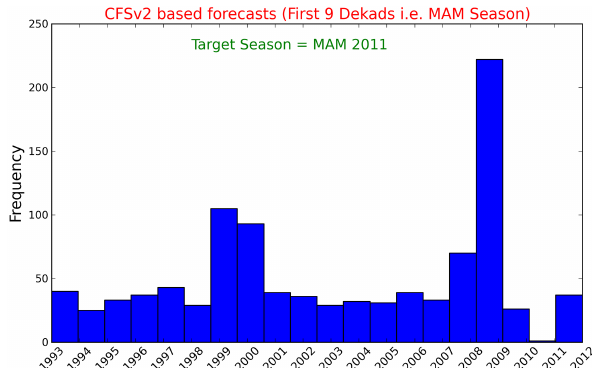
Figure 4. Frequency of picking each climatological year for ge- nerating climate scenarios (conditioned to CFSv2 based weighted probabilities) for the MAM season of the year